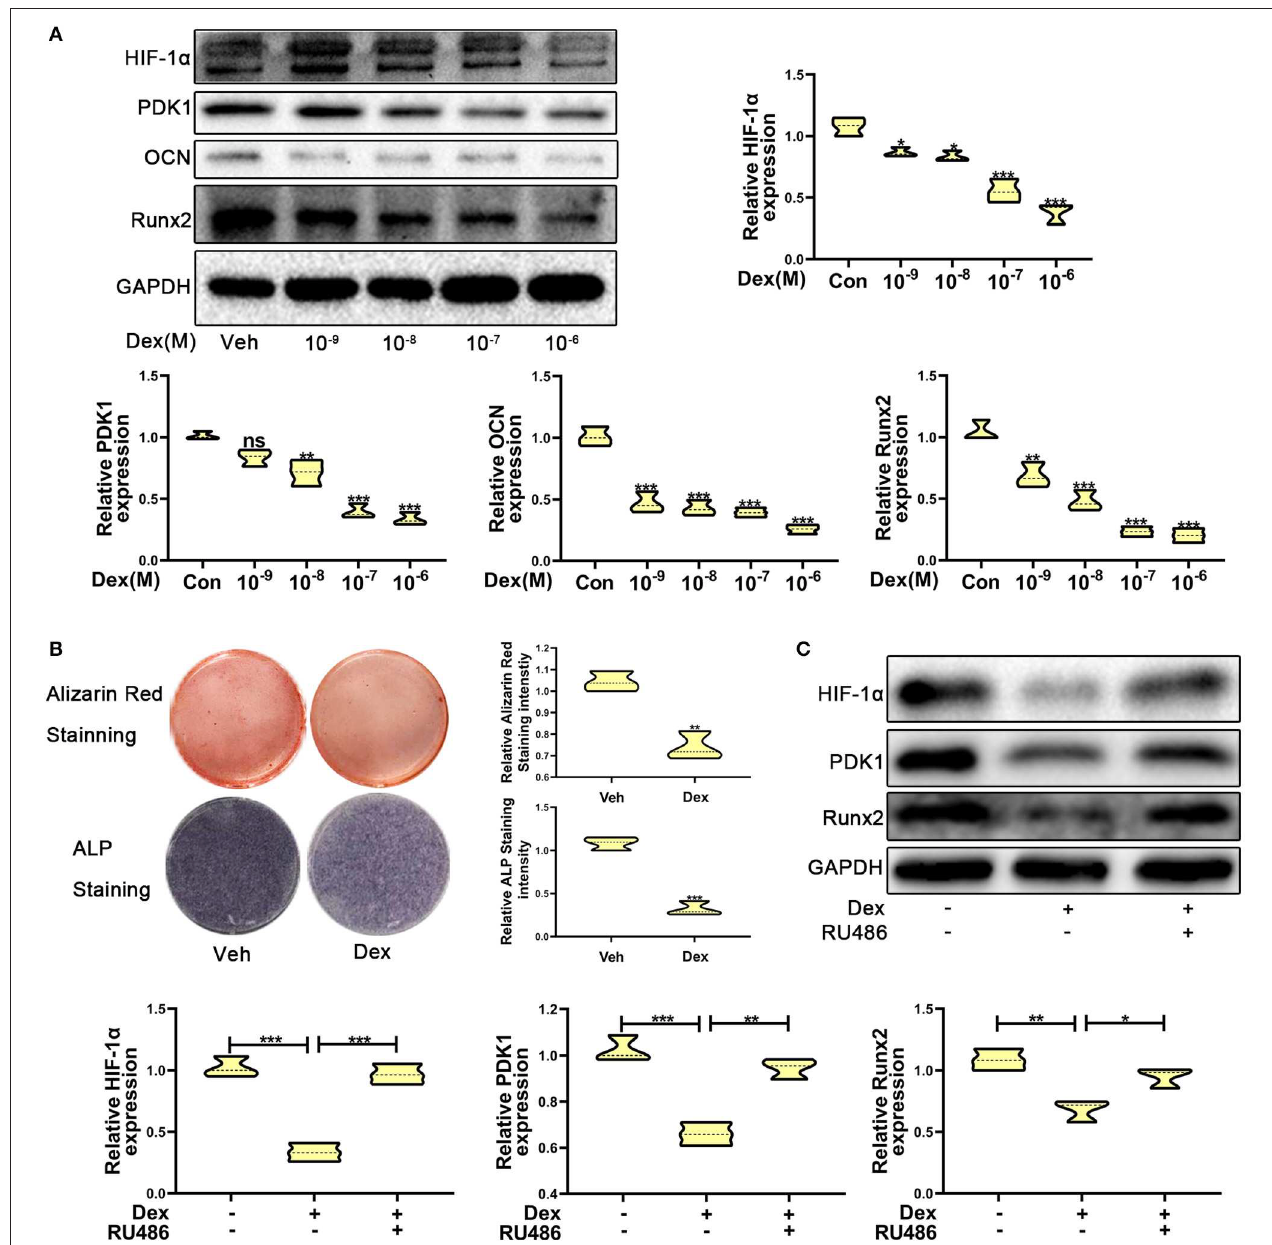
FIGURE 1 | Dexamethasone inhibited the osteogenic function of MC3T3-E1 cells via regulating HIF-1 α expression. (A) The protein expression levels of HIF-1 α , PDK1, OCN, Runx2, and GAPDH were determined by western blotting in MC3T3-E1 cells treated with a varying concentration of dexamethasone for 14 days. (B) ALP and Alizarin red staining were performed to detect the osteogenic function of MC3T3-E1 cells treated with vehicle and dexamethasone. (C) Western blotting was performed to detect the protein expression levels of HIF-1 α , PDK1, Runx2, and GAPDH in MC3T3-E1 cells treated with vehicle, dexamethasone, and dexamethasone + RU486, respectively. Differences were considered as statistically significant when p < 0.05. *** p < 0.001, ** p < 0.01, * p <